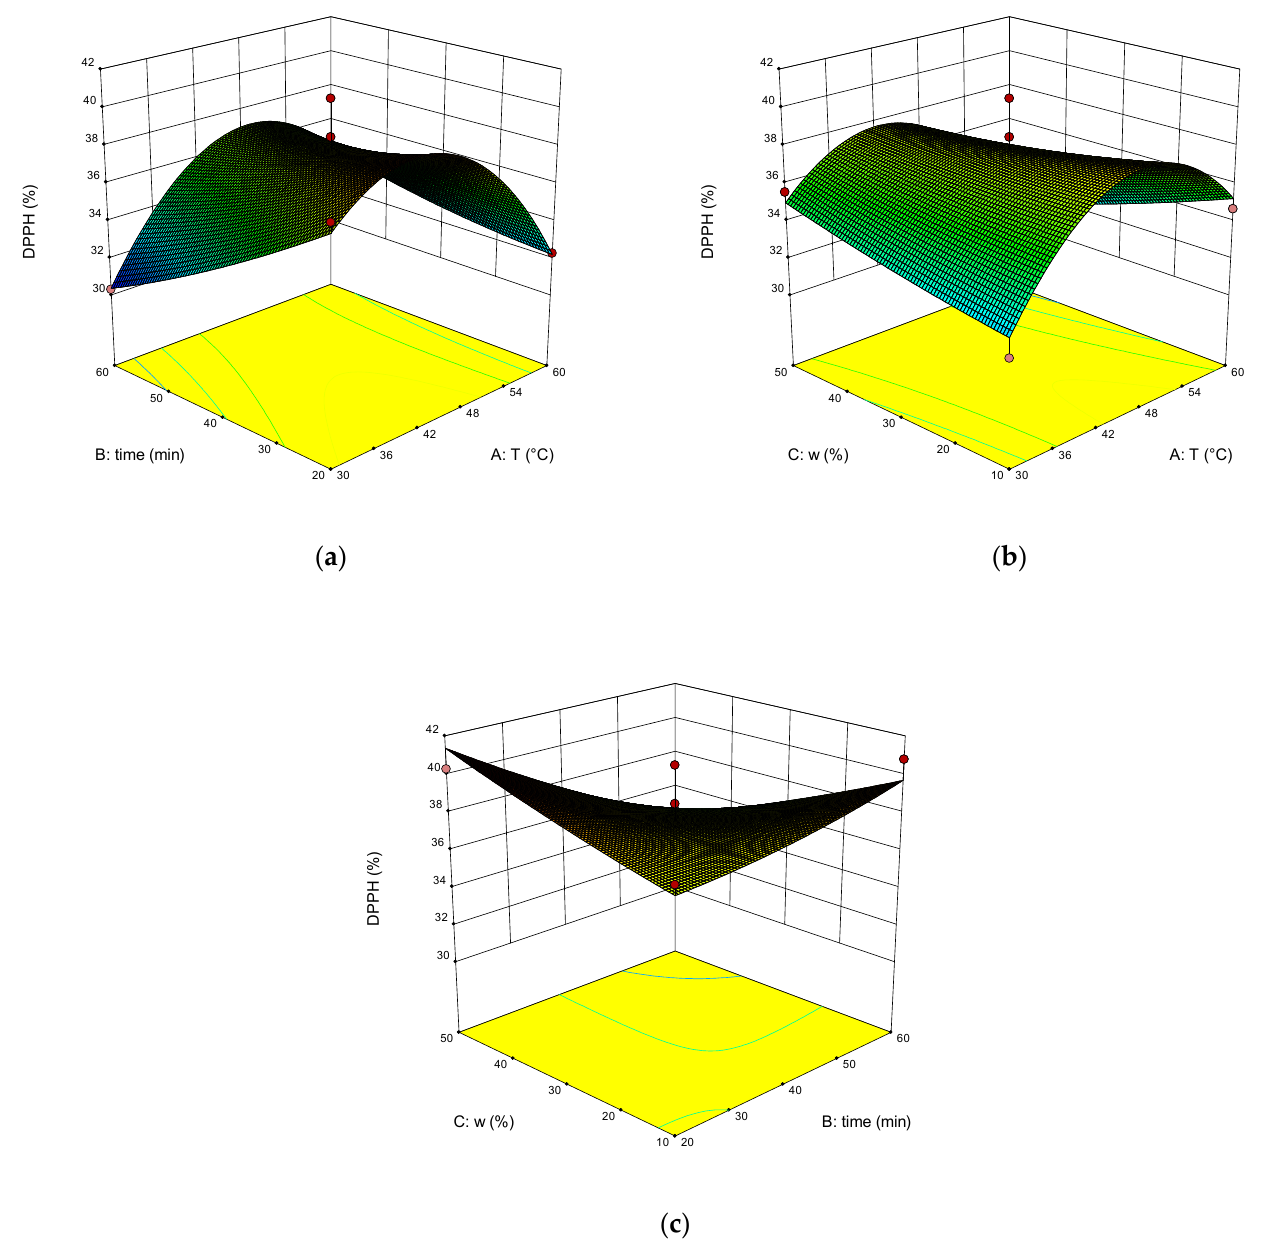
Figure 6. Response surface ( a – c ) shows the extraction temperature (A), extraction time (B) and water content (C) effect on the extraction yield of DPPH.